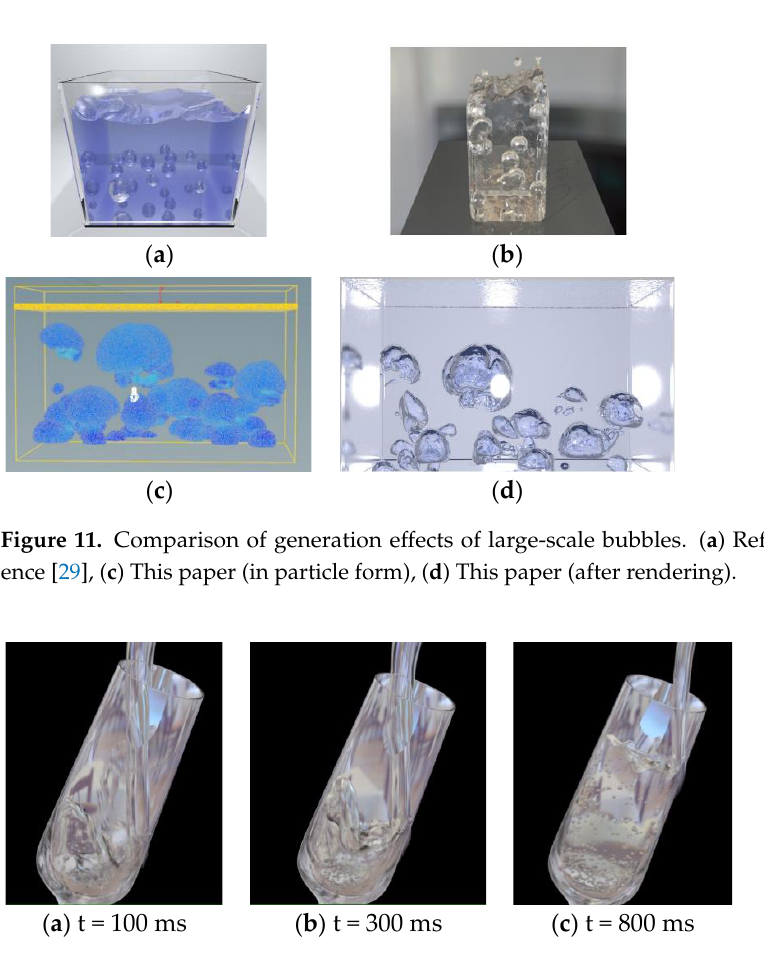
Figure 12. Small-size bubble renderings.